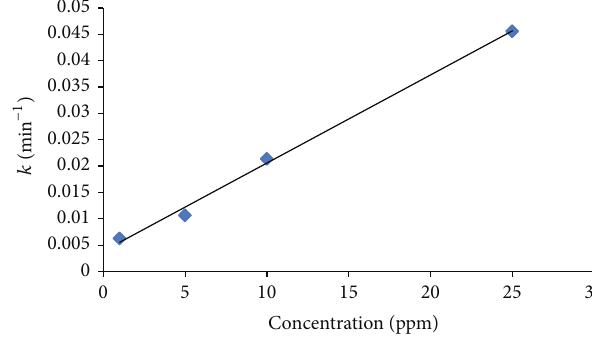
Figure 2: Effects of initial Anthracene concentrations at a rate constant.